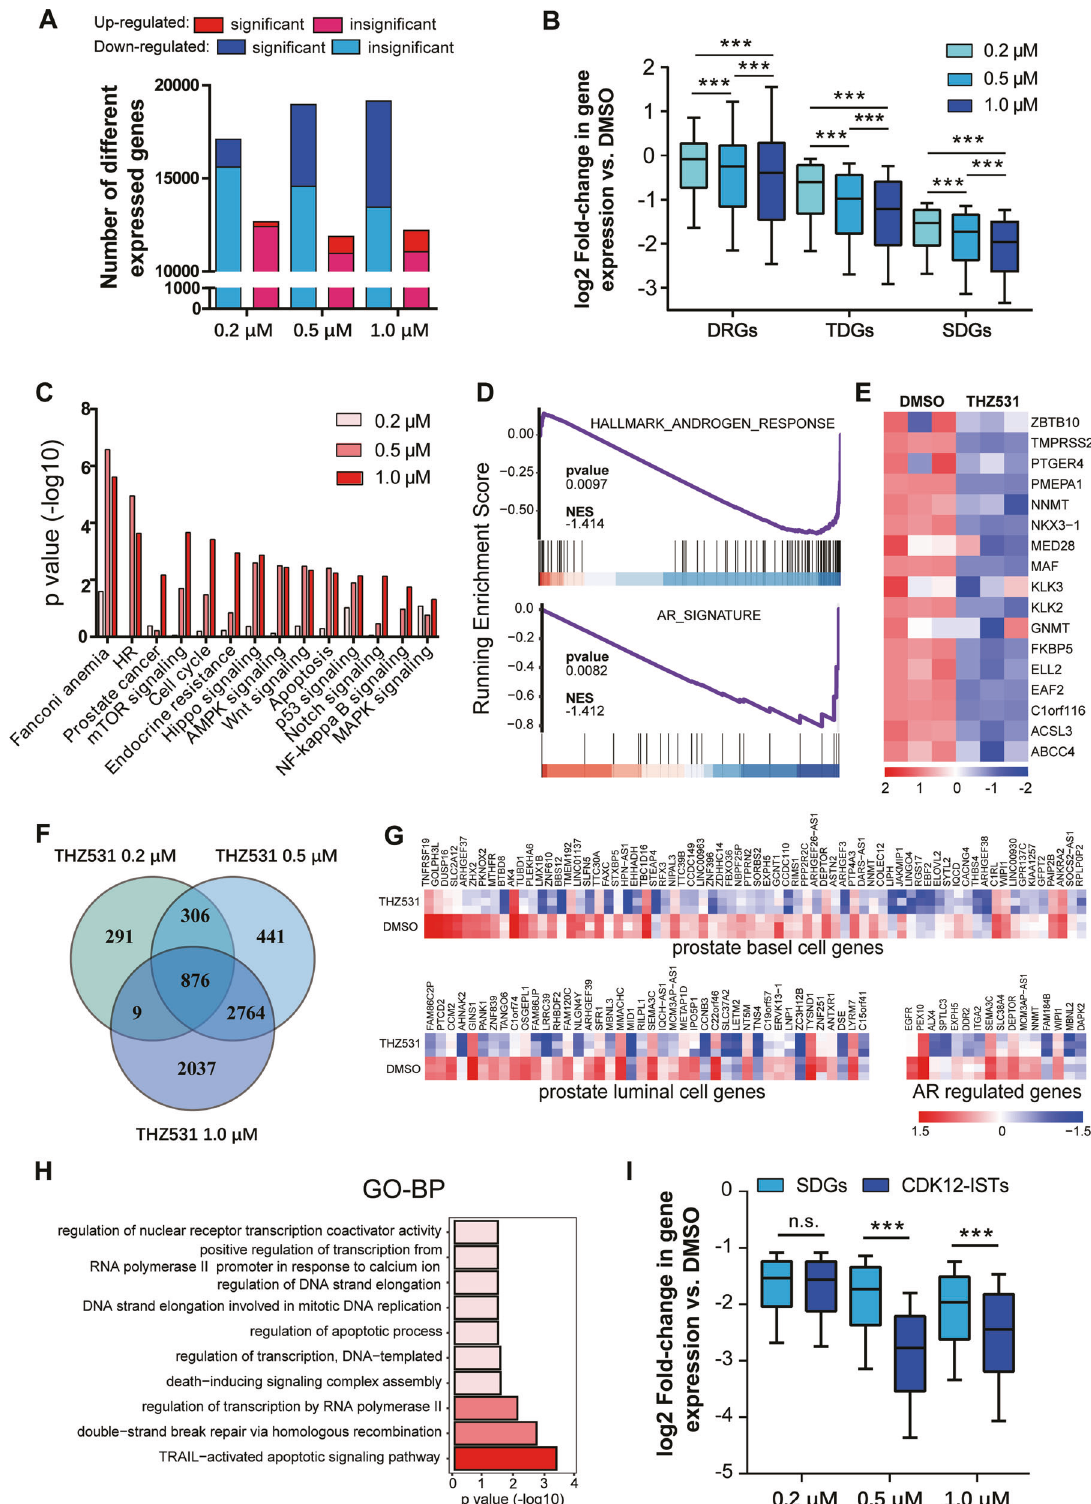
Fig. 3 CDK12-ISTs contribute to the survival processes of PCa cells. A The numbers of differentially expressed genes (DEGs) induced upon either DMSO or THZ531 treatment in LNCaP cells at 6 h. B Log2 fold changes in DEGs, total downregulated genes (TDGs) and signi fi cantly downregulated genes (SDGs) expression induced by THZ531 in LNCaP cells for 6 h. C KEGG analysis of signi fi cant DEGs in LNCaP cells treated with THZ531 for 6 h. D GSEA revealed that gene sets of androgen response and AR signature were signi fi cantly downregulated in THZ531- treated LNCaP cells. E Heatmap showing the downregulation of AR score genes in THZ531-treated LNCaP cells. F Venn diagram showing the SDGs among different doses of THZ531 as CDK12-ISTs. G Heatmap showing the downregulation of prostate basal/luminal cell genes and AR- regulated genes related to CDK12-ISTs. H Enriched GO functional categories of CDK12-ISTs. I Log2 fold changes in the mRNA abundance of CDK12-ISTs and SDGs. Cell Death and Disease (2021)